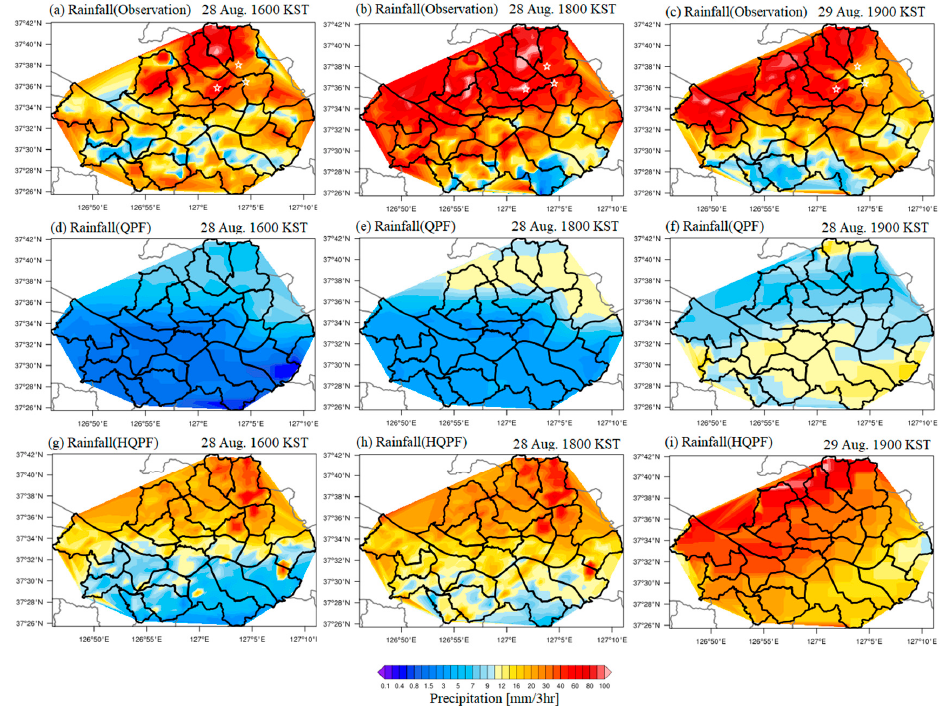
Figure 7. Spatial distribution of a 3 h accumulated rainfall for observation ( upper panels ), quantitative precipitation forecast (QPF) ( middle panels ), and HQPF ( lower panels ) at 16:00 on August 28 ( a , d , g ), 18:00 on August 28 ( b , e , h ), and 19:00 on August 29 ( c , f , i ). The black line in the map denotes the administrative division of the Seoul area, and the stars in ( a – c ) indicate the four sites, Nowon, Jungnang, Dobong, and Gangnam listed in Table 3.